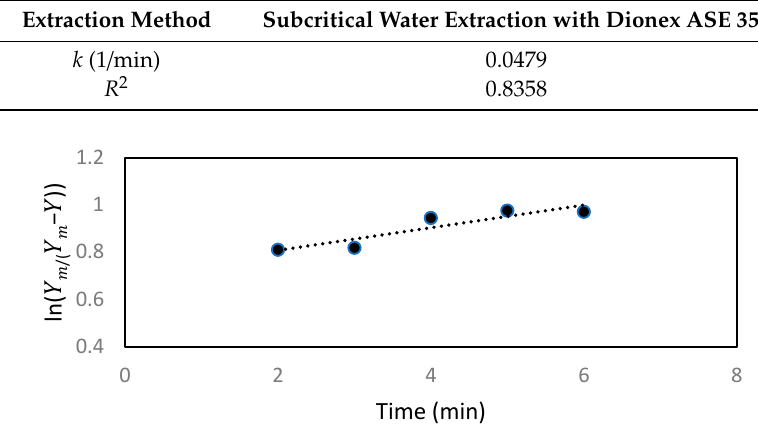
Figure 6. ln(cid:4672) (cid:3026)(cid:3040) (cid:16) (cid:17) Ym (cid:3026)(cid:3040)(cid:2879)(cid:3026) (cid:4673) –T data from EGCG extraction at different condition. Table 5. k and R 2 obtained from model.